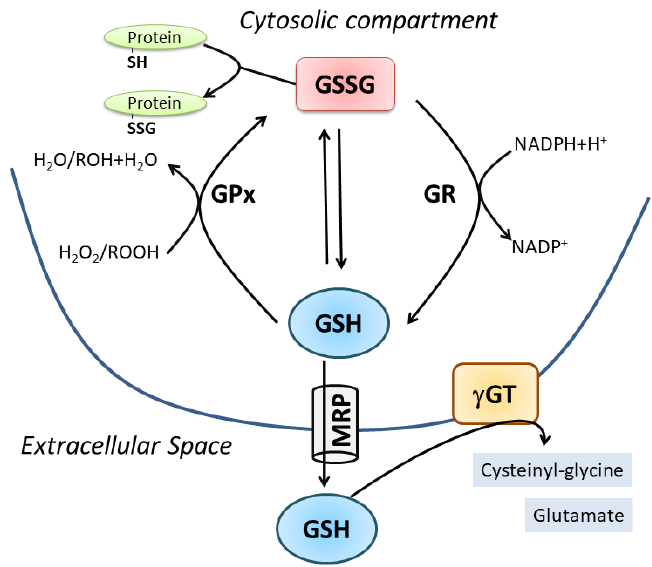
Figure 1. Cellular GSH homeostasis. For details see the text.